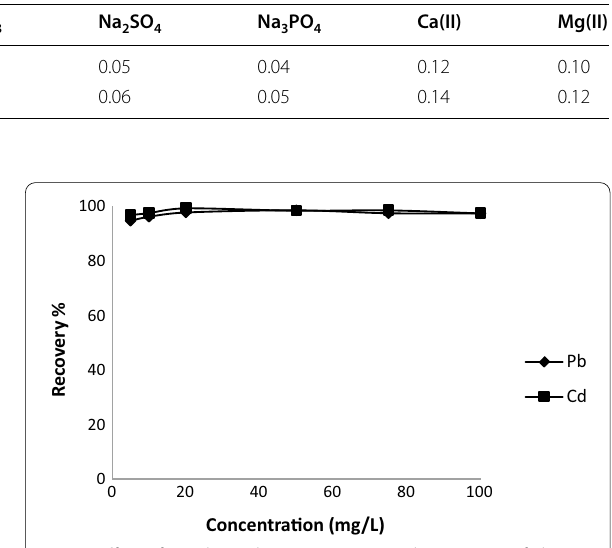
Fig. 4 Effect of initial metal concentration on the recovery of Pb(II) and Cd(II) by modified Amberlite XAD-4 resin (adsorbent amount: 0.2, pH:5, flow rate: 2.5 mL/min)